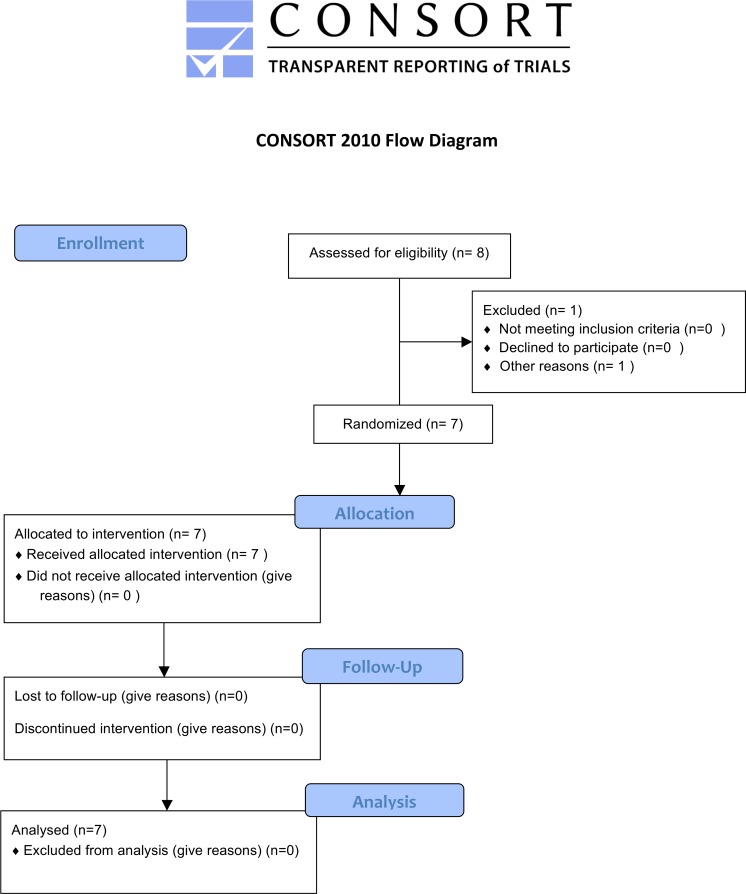
Patient flow-chart.